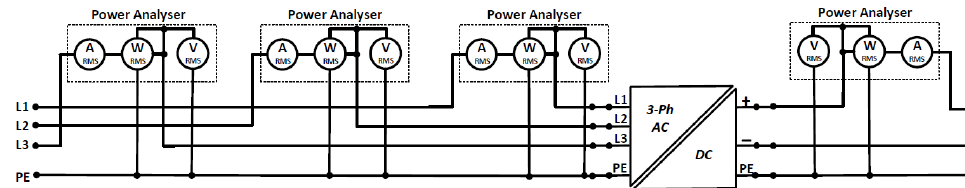
Figure 4. Measurement setup for the bidirectional AC/DC converter.